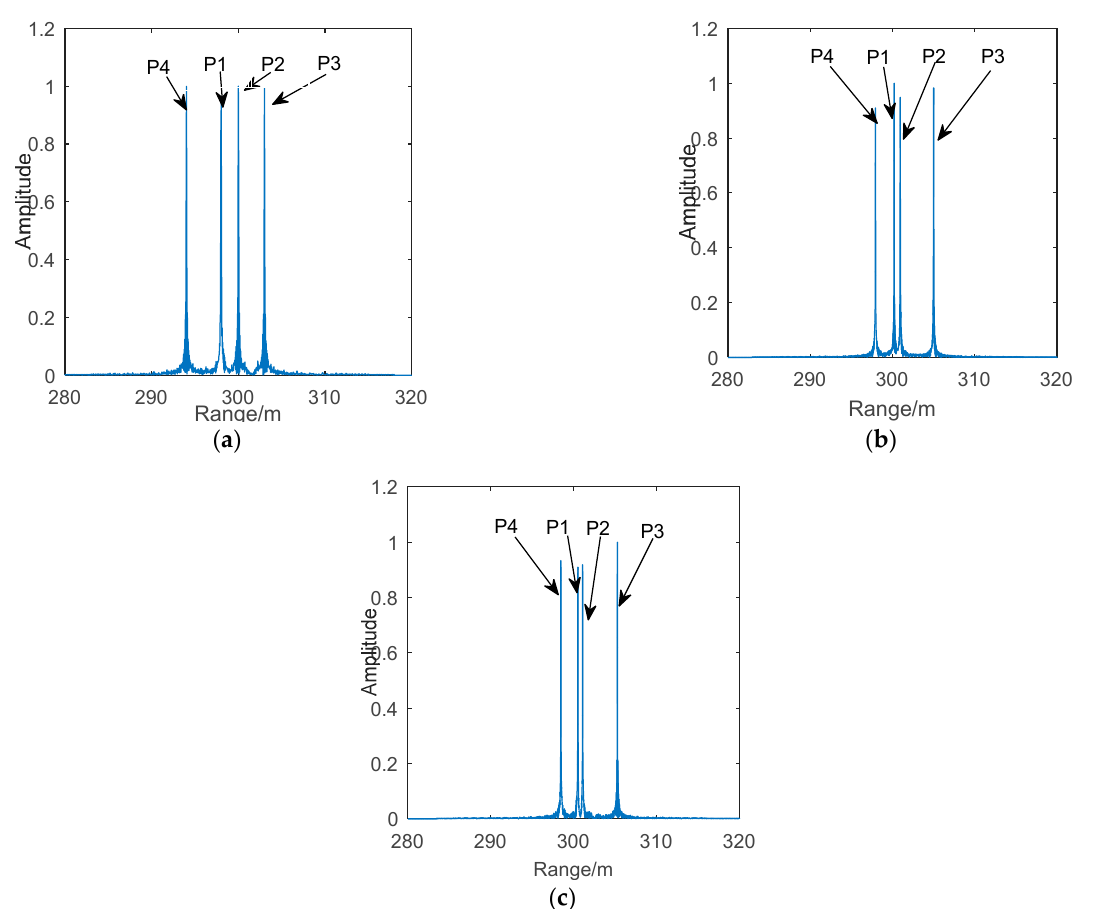
Figure 6. The range imaging results. ( a ) The range imaging in monostatic geometry; ( b ) the range imaging in bistatic geometry of TR1; ( c ) the range imaging in bistatic geometry of TR2. Table 1. The range result in different geometry.